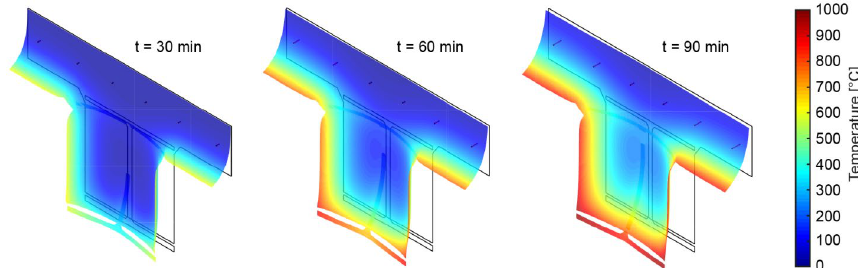
Fig. 7. Temperature fields for 30 (left), 60 (middle) and 90 minutes fire exposition (right)